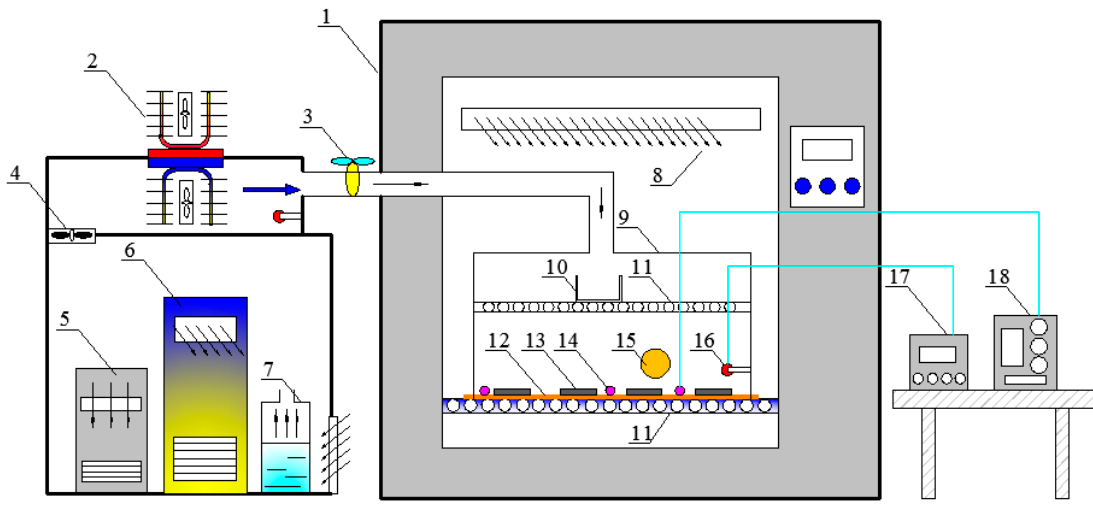
Figure 6. Schematic of the proposed system. 1—low temperature humidity chamber;